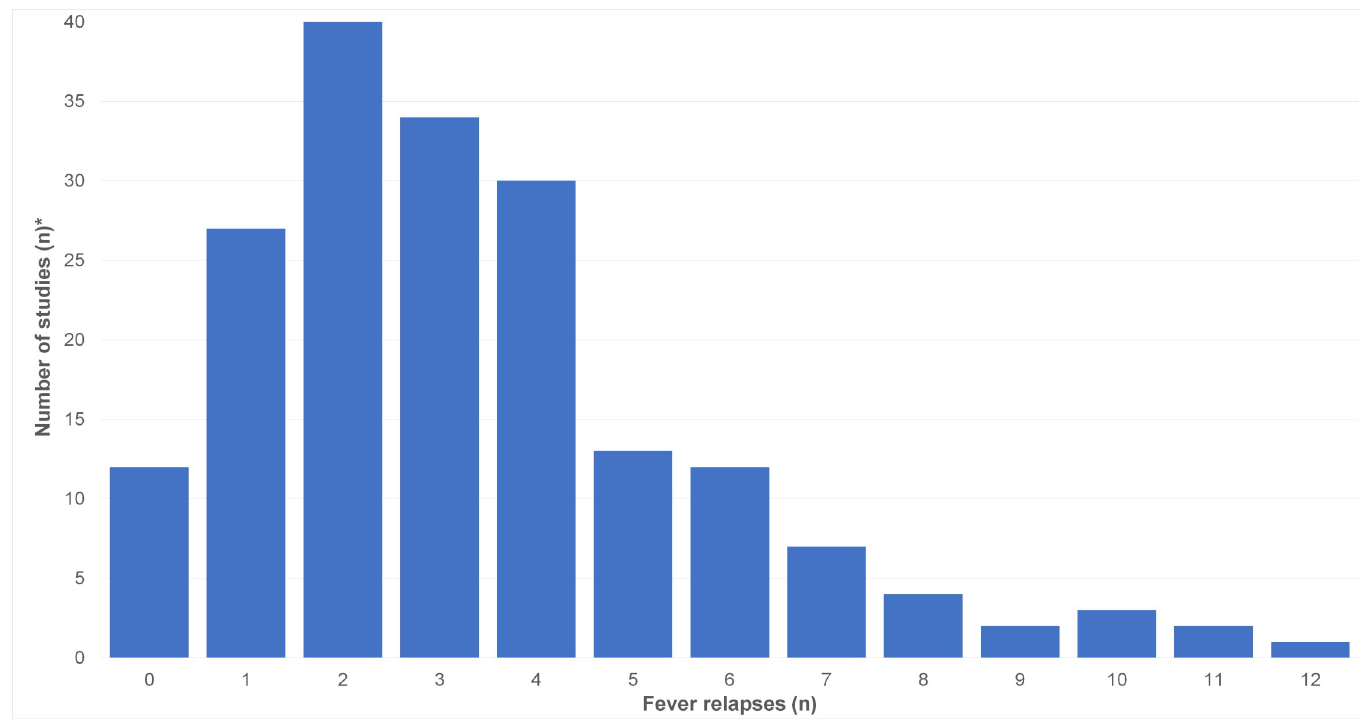
Fig 12. Number of relapsing fever episodes in studies on TBRF (n = 67 studies). � Note: Since the number of relapsing fever episodes within single studies was mostly reported as median, an evaluation per case was not possible.